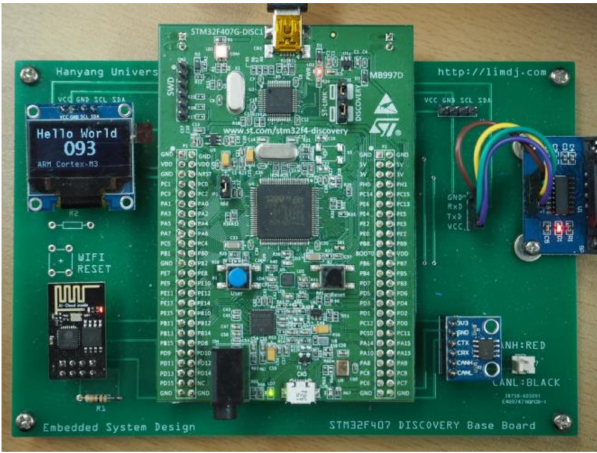
Figure 4. Cortex-M4